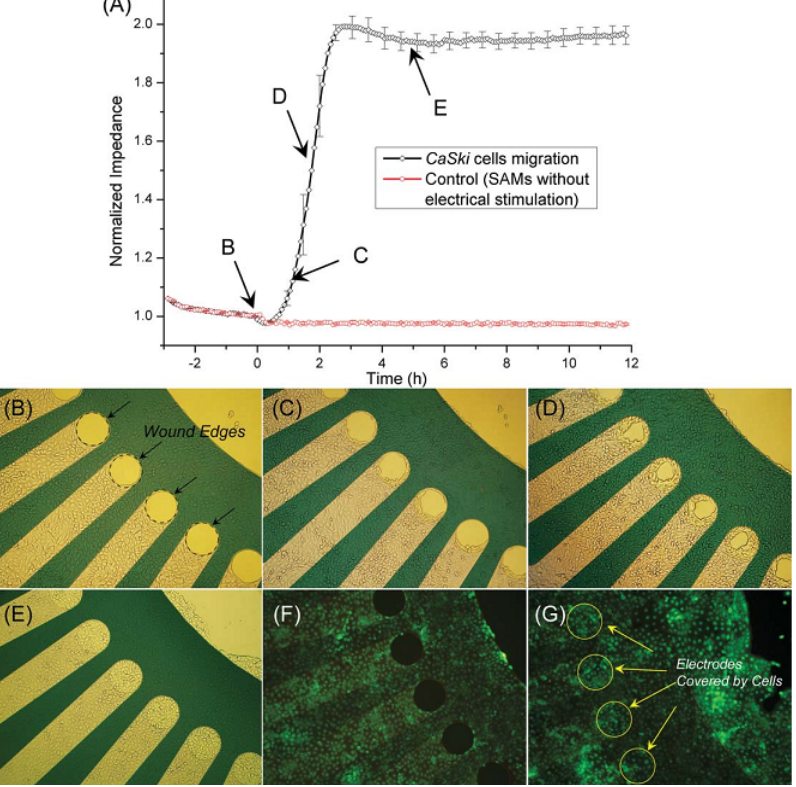
Figure 16. ( a ) The impedance variation for CaSki cells showing the real-time progress of cell migration; ( b – e ) The photographs taken in the progress of cell migration onto the electrodes; ( f , g ) The fluorescence image of the sensor, showing cell viability after modification of the SAMs and application of the DC current (4 times independent repeats for the experimental data). (Reprinted from [42]. © 2012, with permission from the Royal Society of